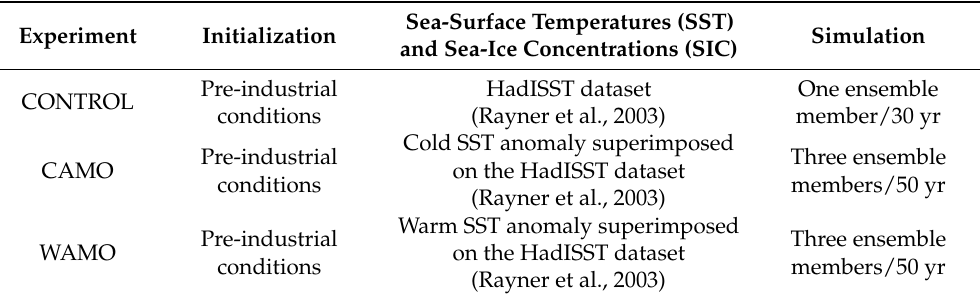
Table 1. Description of the experiments performed with the water isotope-enabled version of the Community Earth System Model version 1 (iCESM1.2).